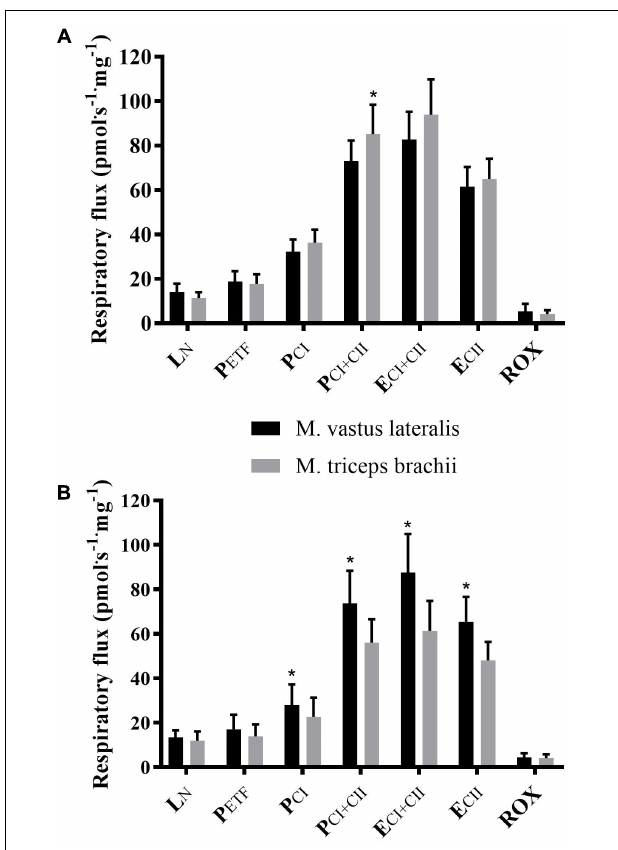
FIGURE 2 | Differences in respiratory flux between M. triceps brachii and M. vastus lateralis in XC skiers and CON. (A) elite cross-country skiers (XC skiers) and (B) physically active controls (CON). Respiratory flux expressed as mass-specific respiratory capacity (pmol · s − 1 · mg − 1 ) for leak respiration in absence of adenylates (L N ), fatty acid oxidative capacity (P ETF ), complex I respiration (P CI ), complex I and II respiration combined (P CI + CII ), electron transfer system capacity (E CI + CII ), electron transfer system capacity of complex II alone (E CII ) and residual oxygen consumption (ROX). Data are displayed as means ± SD. ∗ Significant difference between muscles ( P < 0.001).